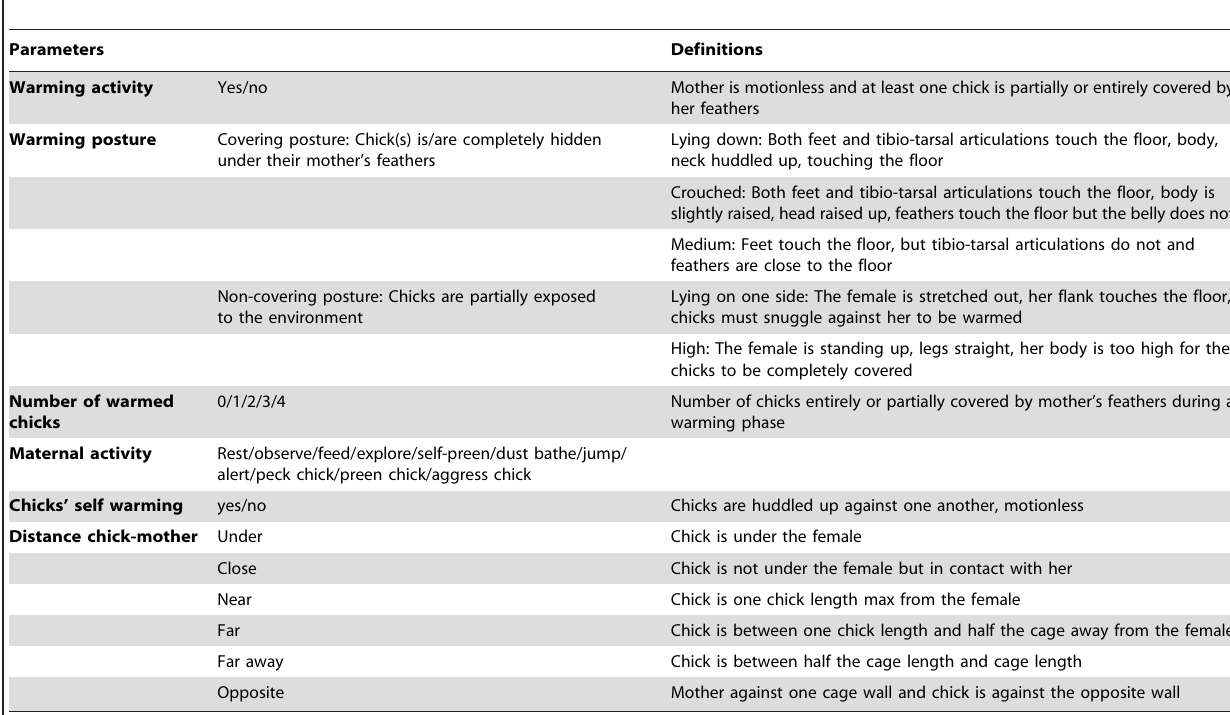
Table 1. Parameters and definition of behavioural traits recorded during the scan sampling observation sessions.